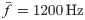
Model responses to an up and a down sweep.A-E show the responses to an up sweep, and F-J to a down sweep. From top to bottom: (A/F) the instantaneous predicted firing rate of the up-selective excitatory populations in the sweep layer; (B/G) the instantaneous firing rate of the down-selective excitatory populations in the sweep layer; (C/H) the instantaneous firing rate of the populations in the spectral layer and, in the right of the panels, a schematic view of the probability distribution of pitch derived from this representation; (D/I) the output of the model of the auditory periphery; (E/F) the instantaneous frequency of the sweeps along time. In all panels except for E/J, y-axis represents the cochlear channel n, ordered from bottom (lowest best frequency) to top (highest best frequency). The stimuli were the up and a down sweeps with Δ = ±300Hz and f‾=1200Hz used in the experiment.